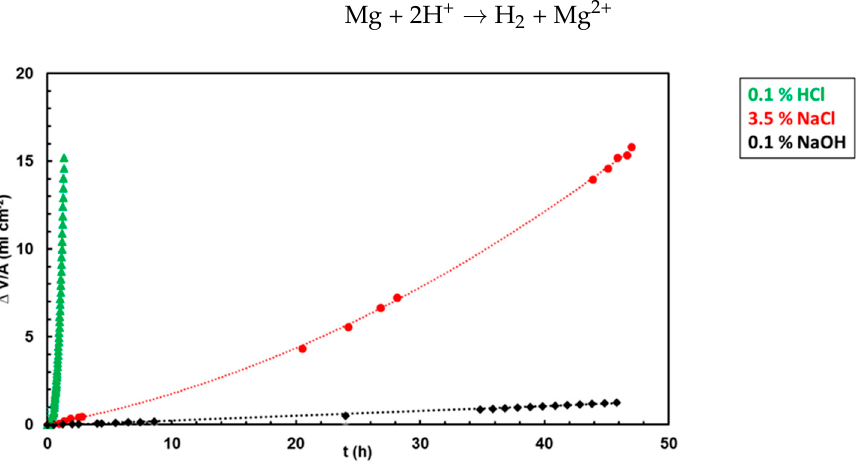
Figure 3. Hydrogen evolution volumes of the Mg 2 Sn alloy in 0.1% HCl, 3.5% NaCl and 0.1% NaOH.